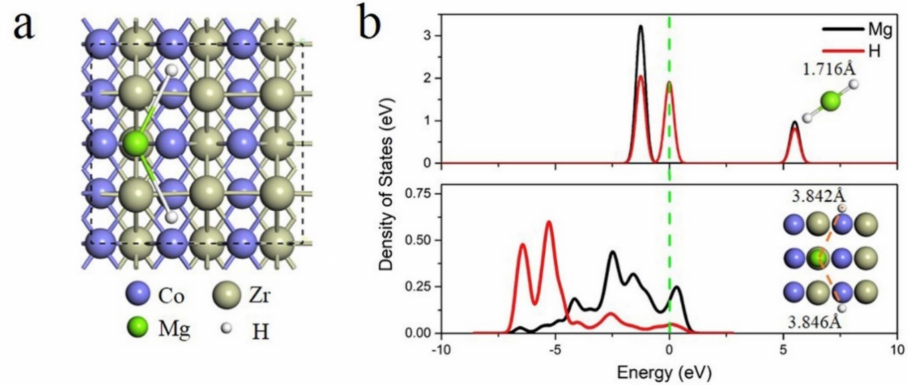
Figure 13. The MgH 2 absorption on ZrCo (110). The adsorption configuration ( a ) and the corre- sponding density of states ( b ) [123]. (Reprinted with permission from